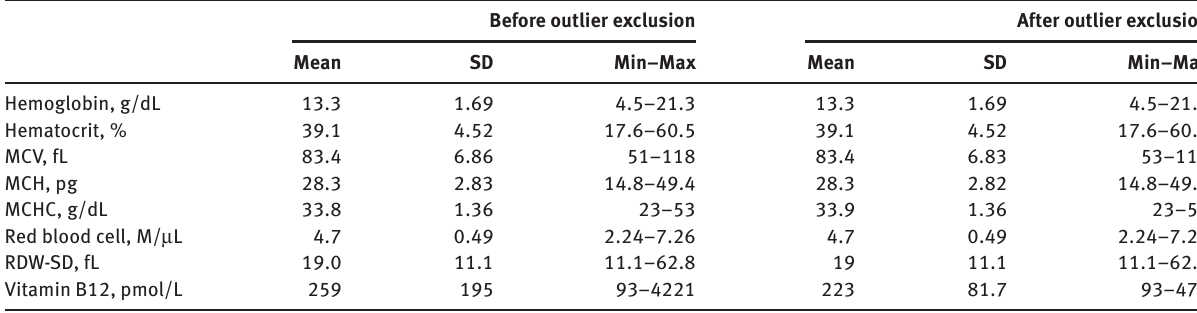
Table 1: Laboratory data before (n = 15,455) and after (n = 14,748) outlier exclusion. Before outlier exclusion After outlier exclusion